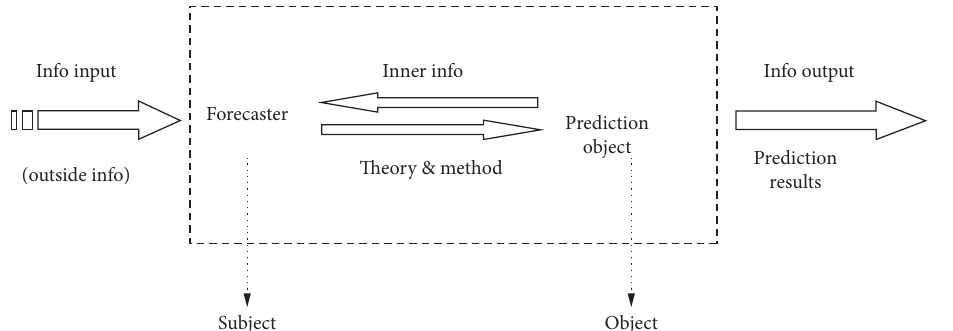
Figure 1: Elements of economic system